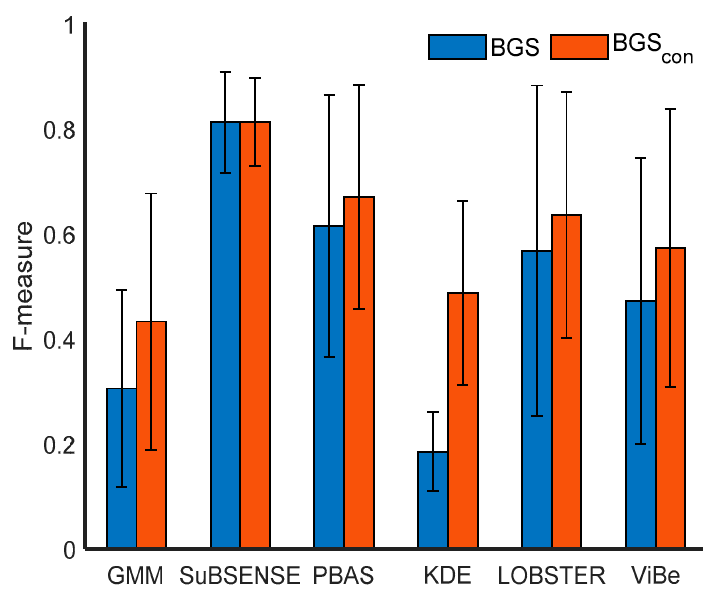
Figure 5. Comparisons of the increased F-measure values.